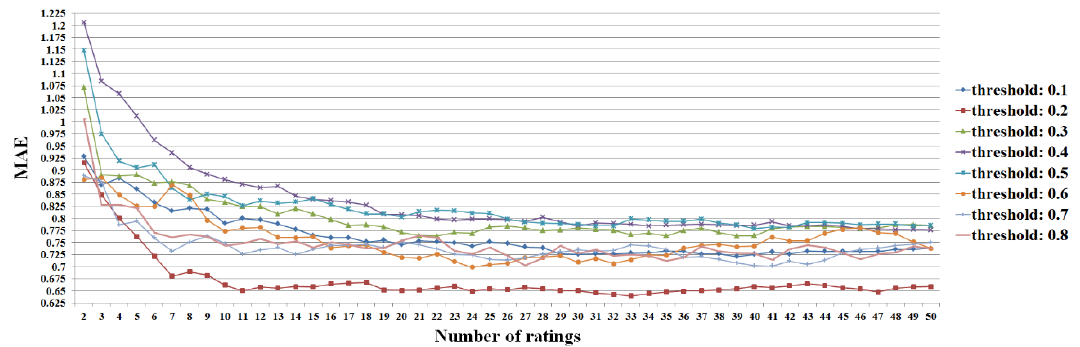
Figure 26. Verification process of the item-based filtering .